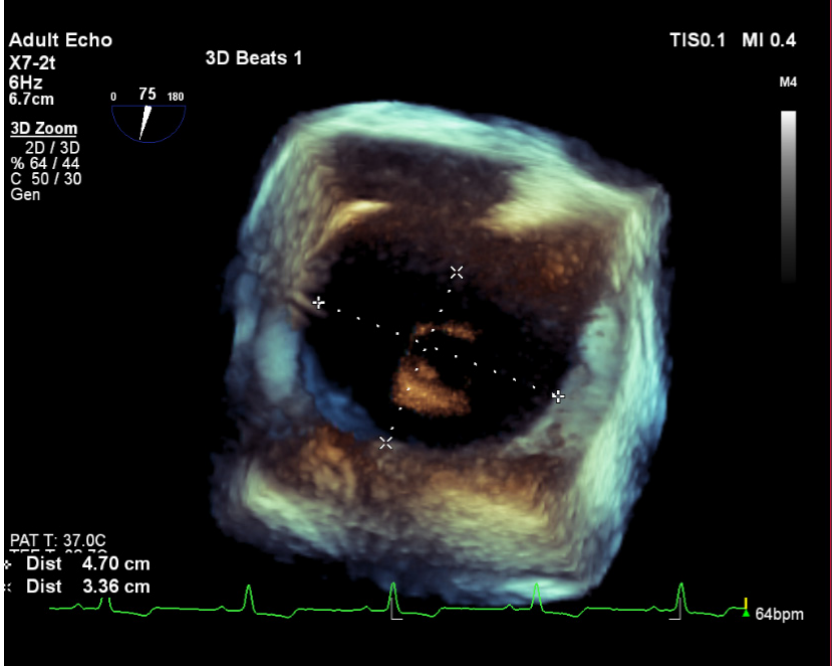
Figure 4. 3D Transesophageal echocardiography showing the size of the atrial septal defect.